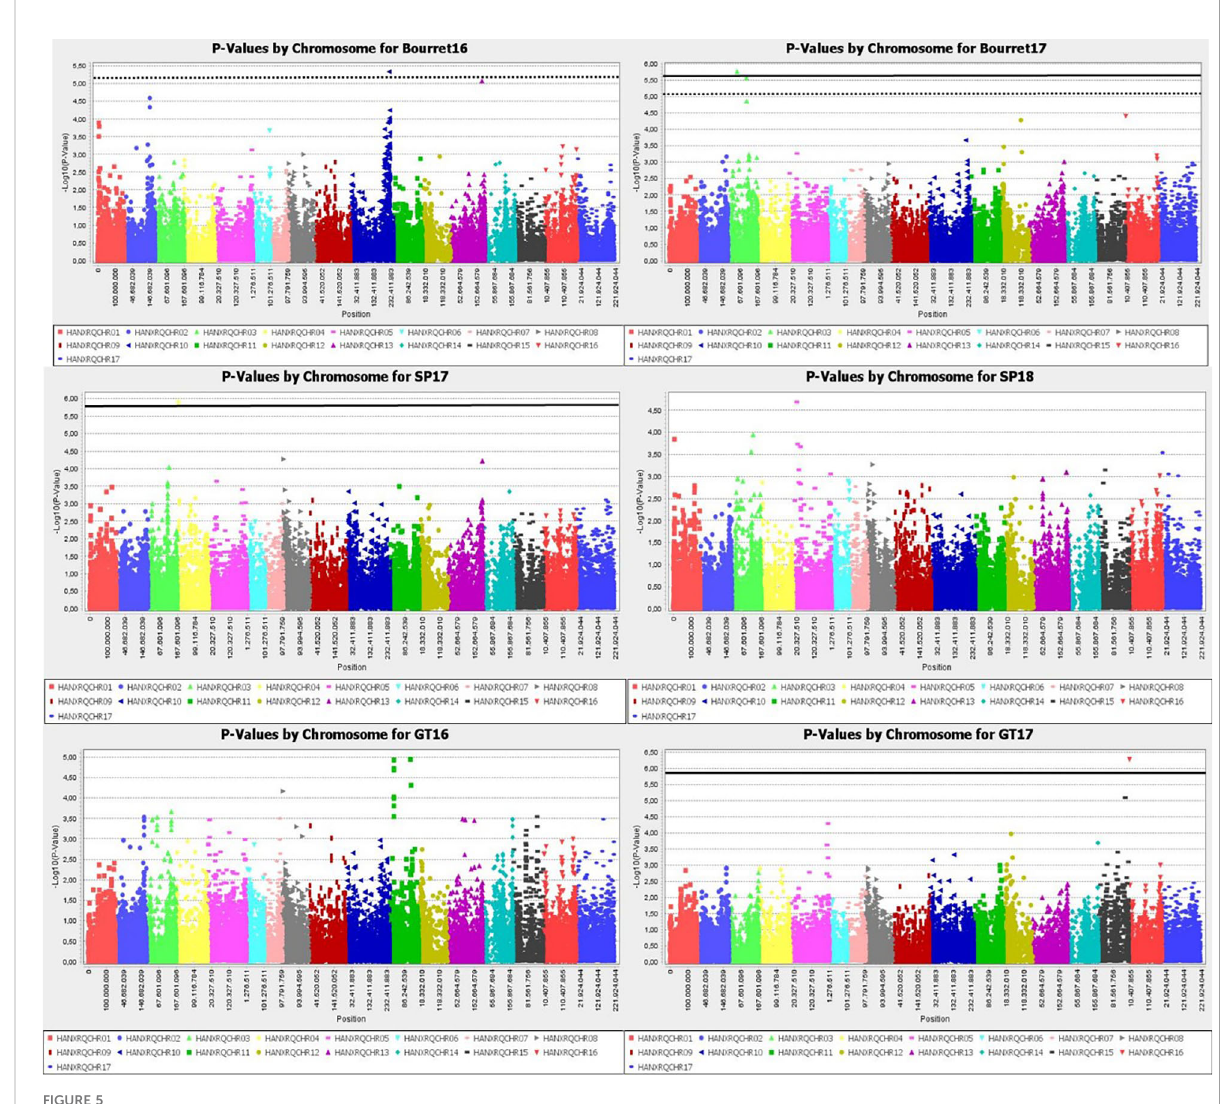
FIGURE 5 Manhattan-plots illustrating signi fi cant associations for resistance to three broomrape populations (SP, Bourret and GT) in a panel of 104 sun fl ower accessions evaluated in two environments each using MLM+K+PCA. The P values were adjusted using the Bonferroni threshold and false detection rate (FDR) correction (5% and 20%) to reduce false positive associations. The solid line corresponds to the 5% threshold and the dotted line to the 20% threshold. The vertical axis indicates – log10 of p-value and horizontal axis indicates chromosomes and physical positions of